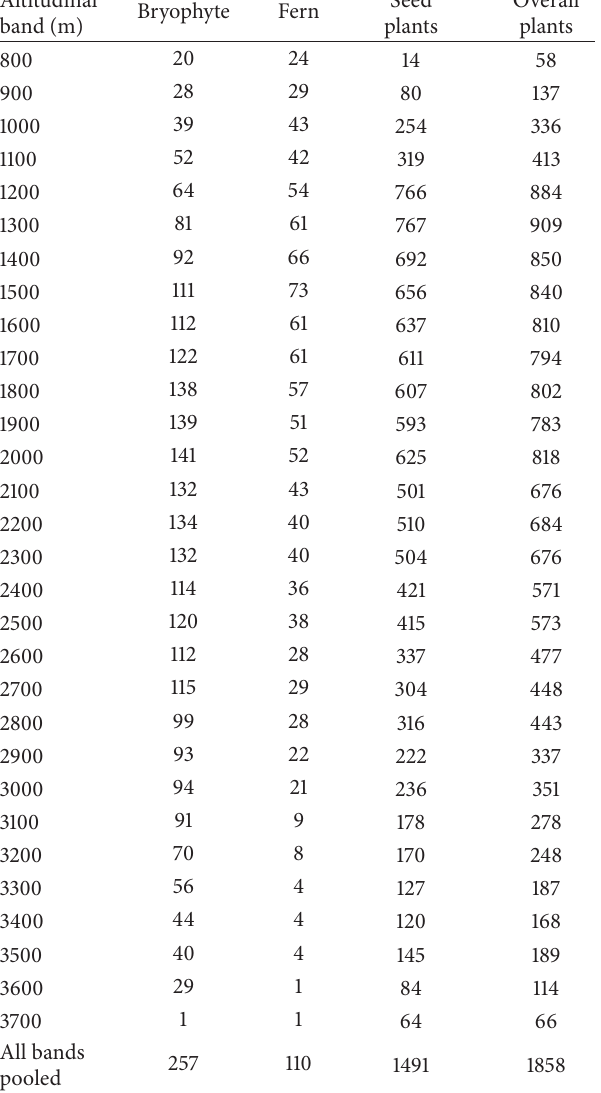
Table 1: Empirical species richness estimates for different eleva- tional bands in Taibai